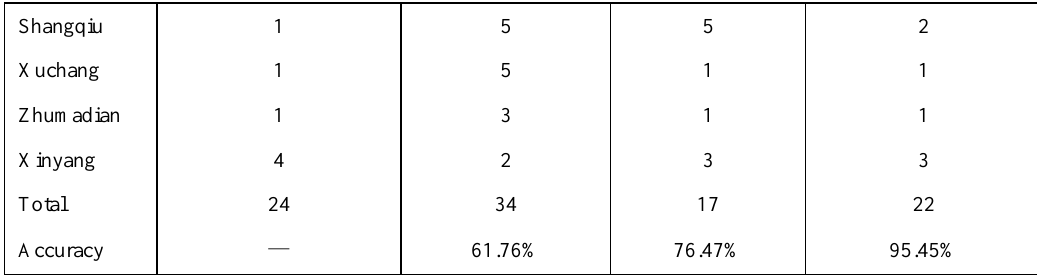
Table 2 . Statistical table of verification results of quantity of straw burning fire points on June 11, 2014.